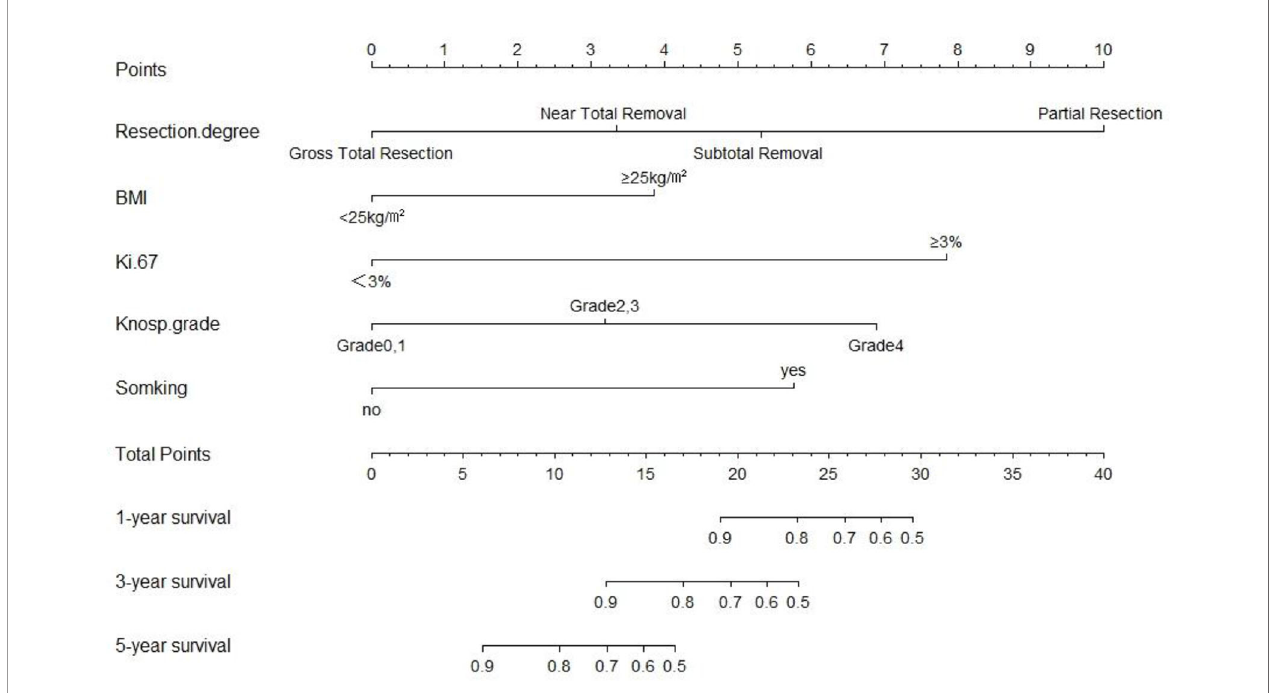
FIGURE 3 | The predictive nomogram based on resection degree, BMI, Ki-67, Knosp classi fi cation and smoking